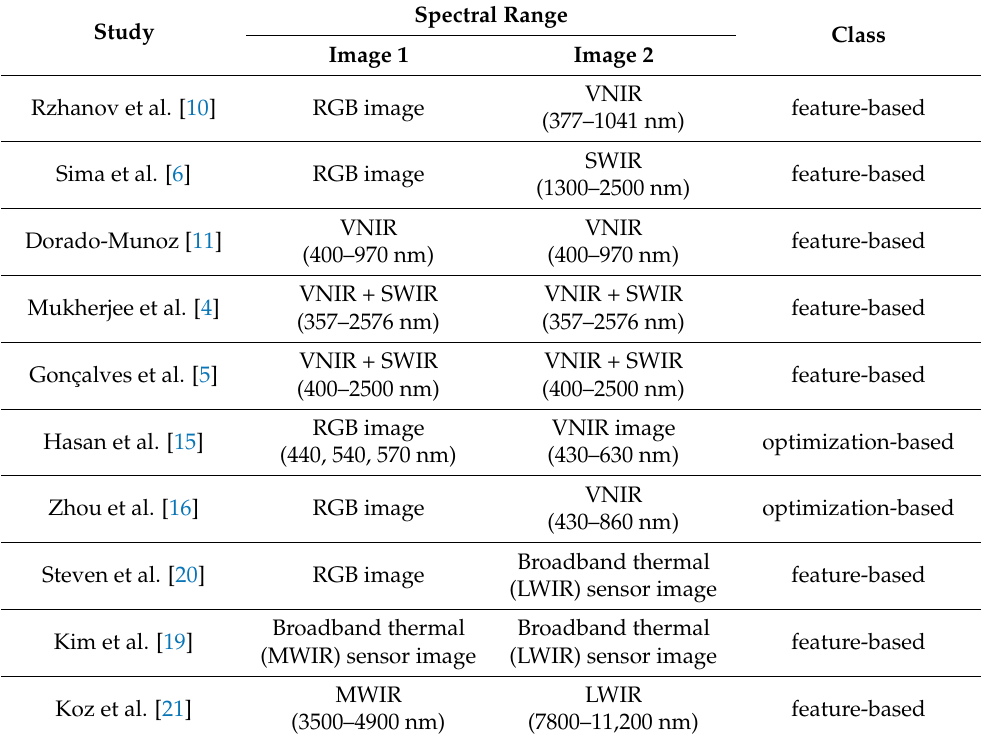
Table 1. An overview of hyperspectral image registration methods with the spectral range of image